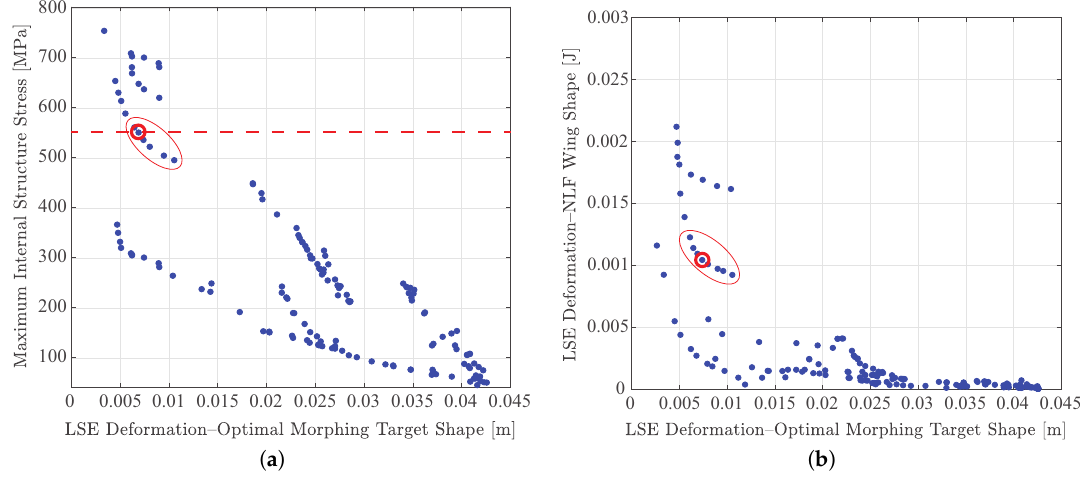
Figure 13. Pareto front, selected Pareto-optimal region, and selected design point: shape-adaptable design vs. stress minimization ( a ) and shape-adaptable design vs. structure design ( b